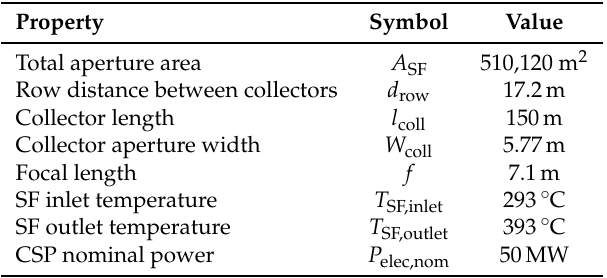
Table A1. Main characteristics of the 50 MW CSP-TES Andasol 1 power plant adapted from Silva et al. [62] (Appendix A). Property Symbol